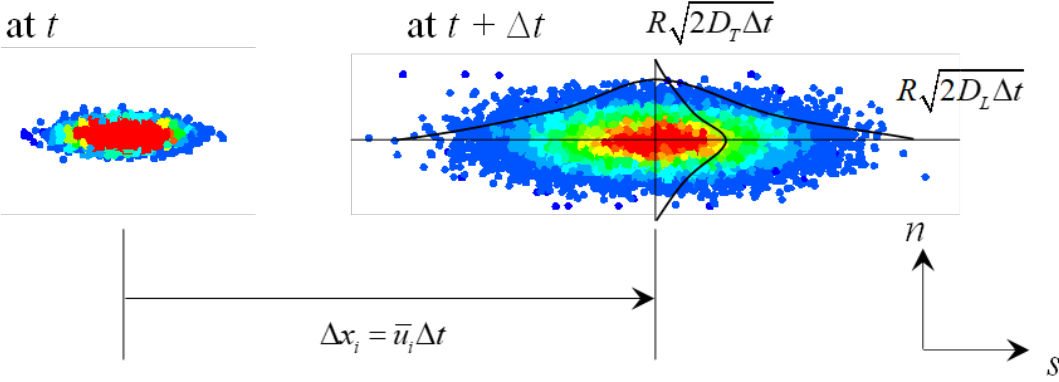
in Figure 2. Pollutant cloud is transported by the depth-averaged velocity fields, and the scale of longitudinal ( s ) and transverse ( n ) direction mixing is determined by the computation of the random transport term.